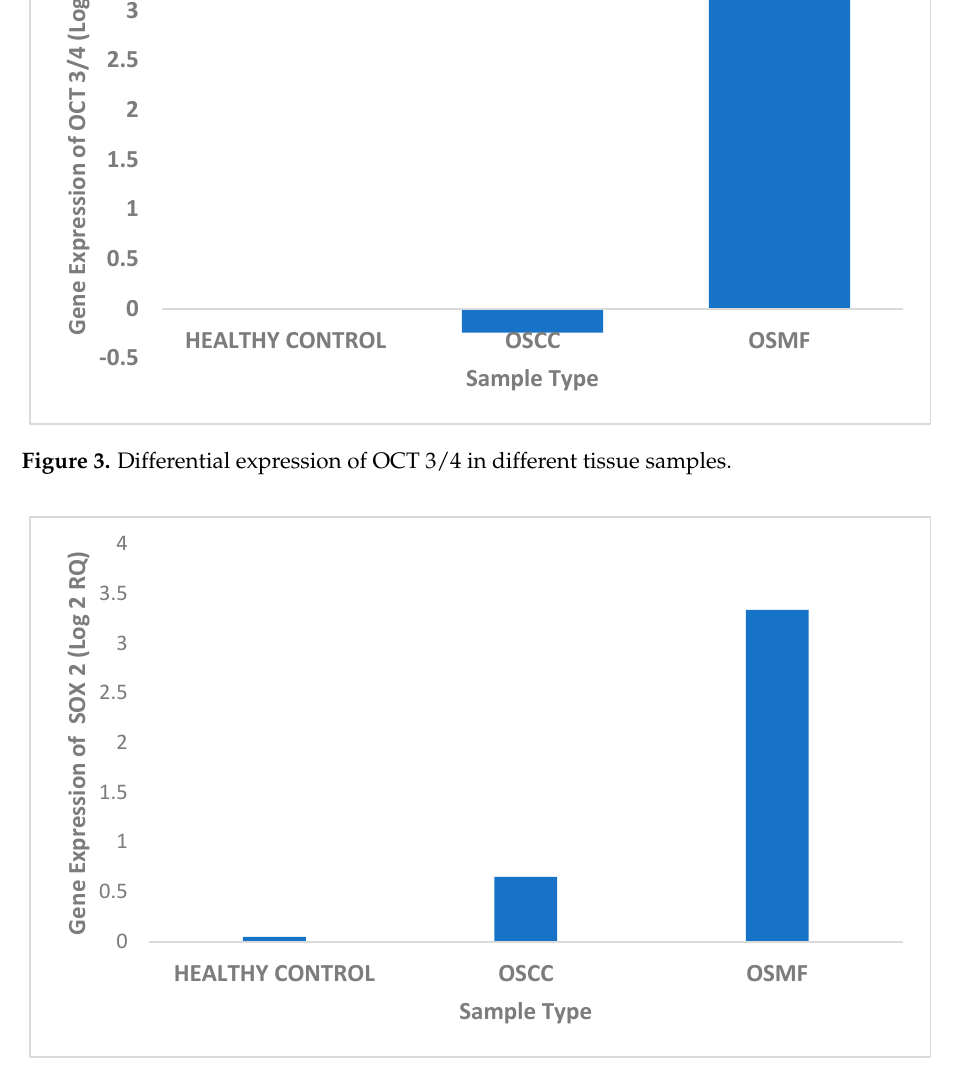
Figure 4. Di ff erential expression of SOX 2 in di ff erent tissue samples. Figure 4. Differential expression of SOX 2 in different tissue samples. Table 5. Expression levels of SOX 2 in OSCC, OSMF and healthy control